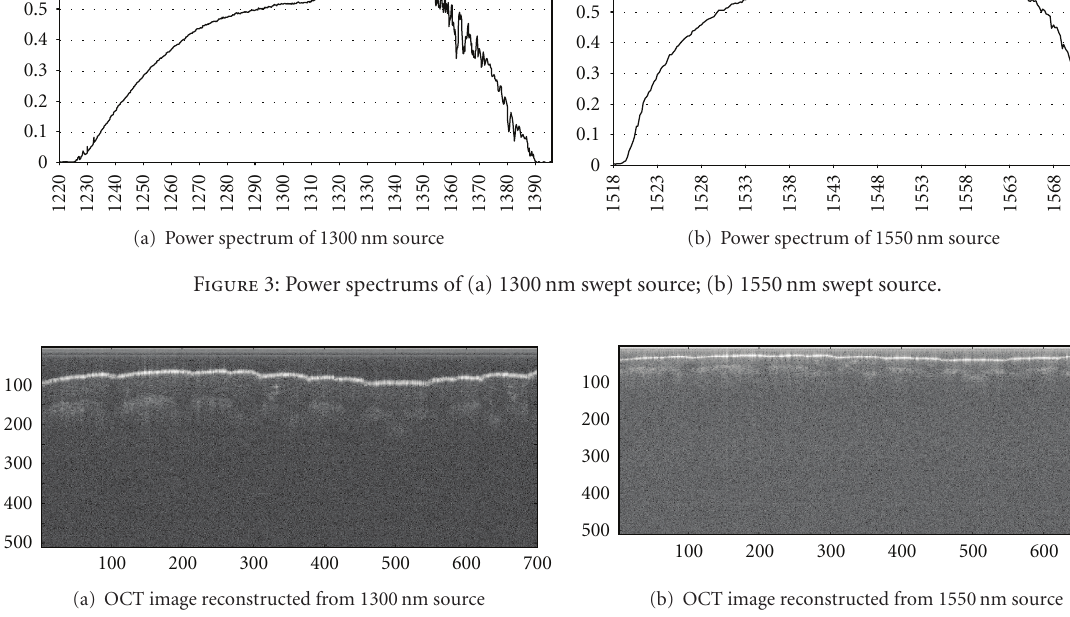
two synchronized swept sources, a wavelength-division mul- tiplexing, and a sharing common path fiber-lensed